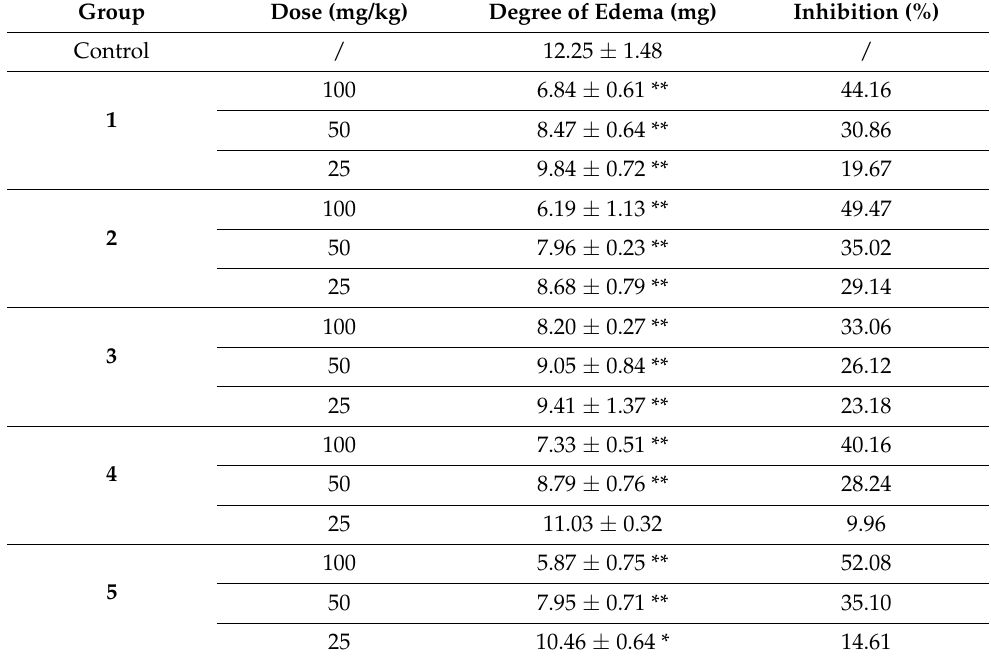
Table 4. Effect of 1-methylhydantoin cinnamic imides on xylene-induced ear edema in mice. Group Dose (mg/kg) Degree of Edema (mg) Inhibition (%) Control